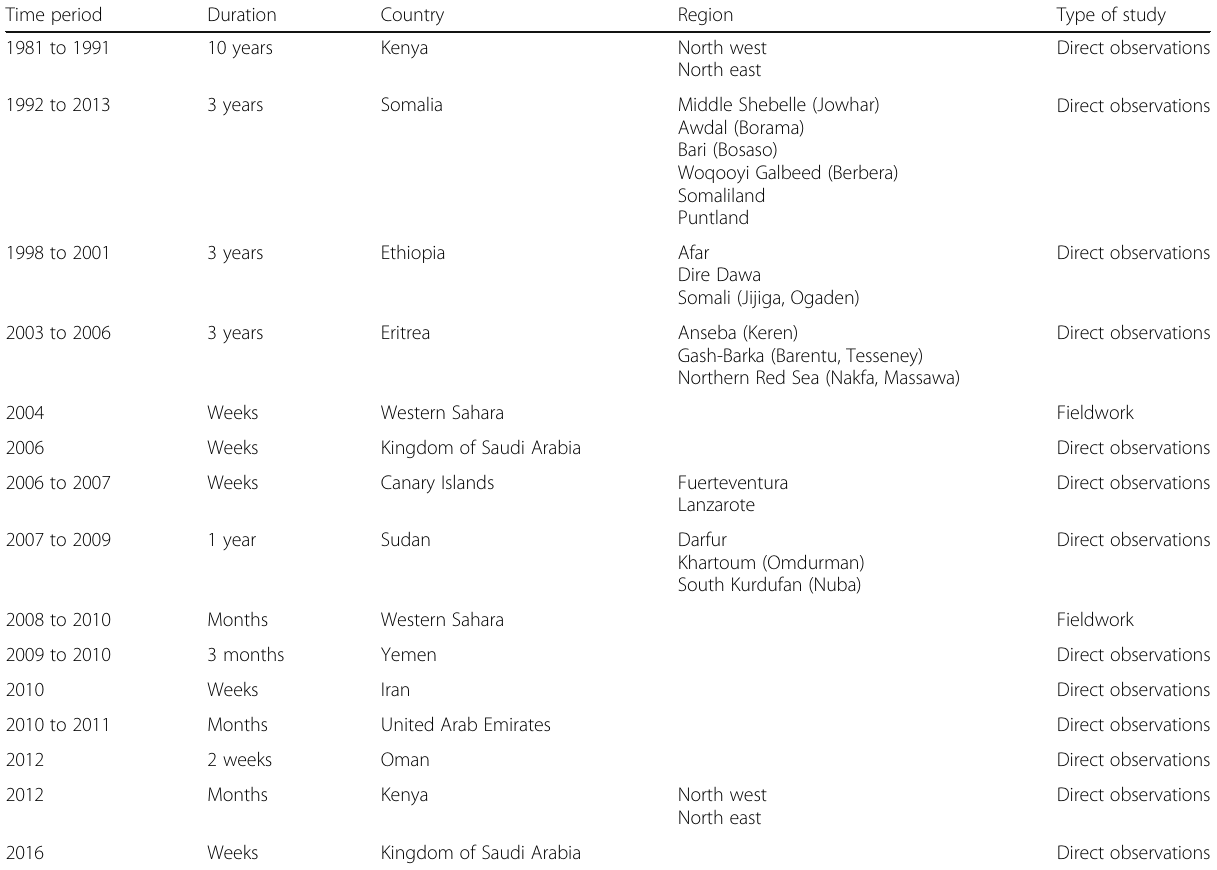
Table 1 Location, duration, and time periods of fieldwork and direct observations Time